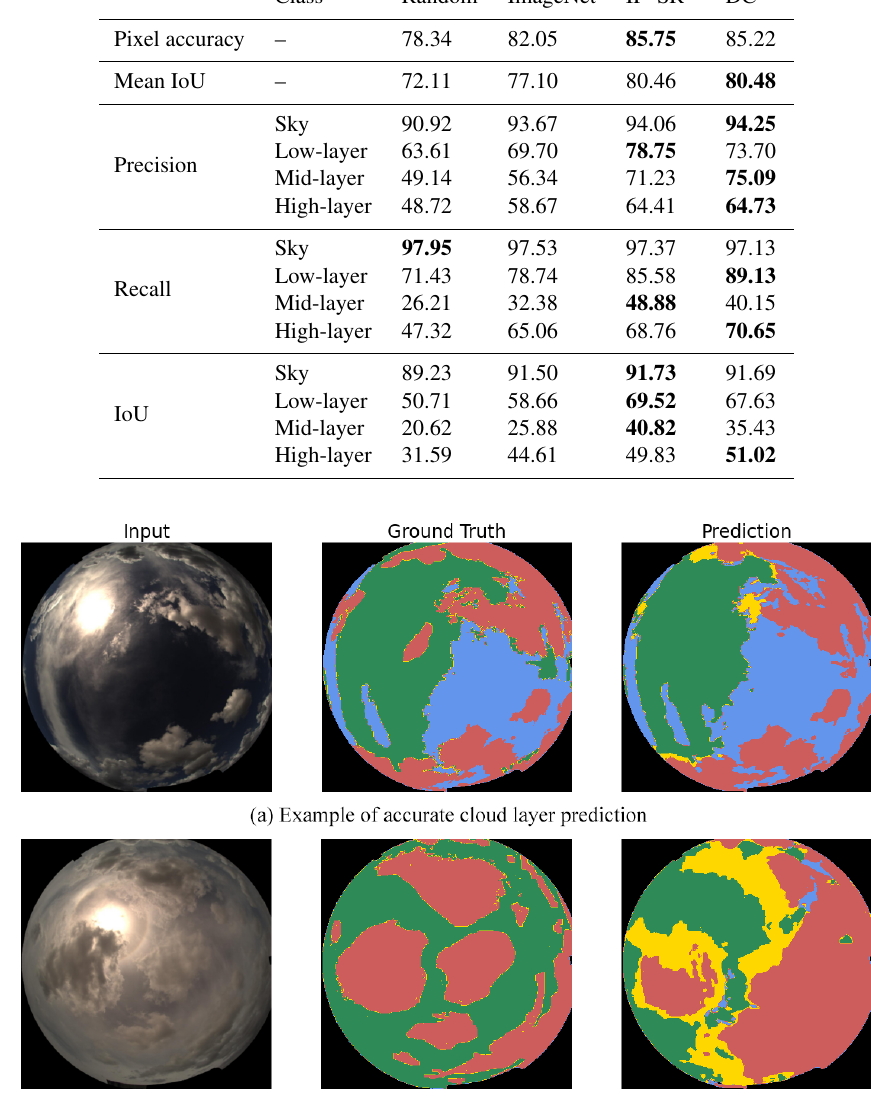
Figure 7. Positive and negative prediction examples compared to ground truth for a given input from the validation set (blue: sky; red: low layer; yellow: mid-layer; green: high